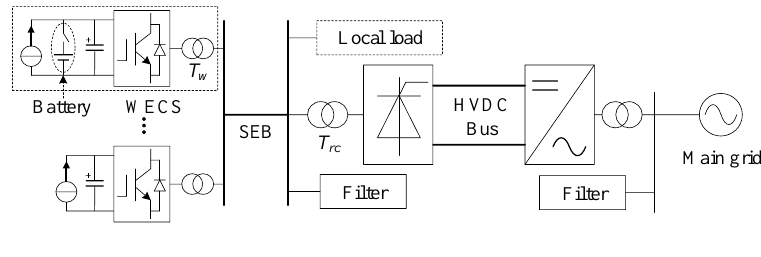
Figure 1. System topology.